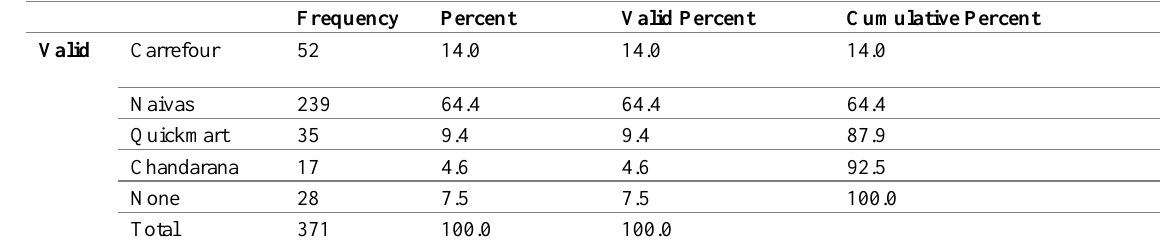
Table 10: Qualification of